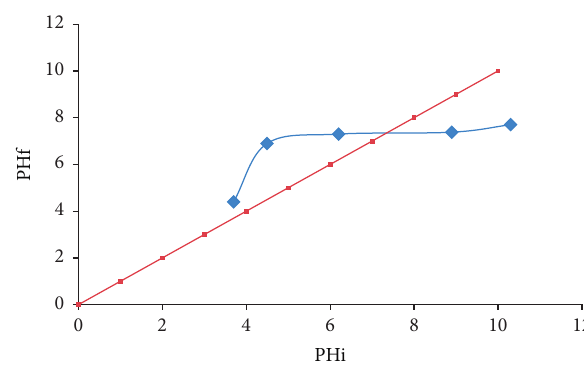
Figure 6: pH zero point determination curve.